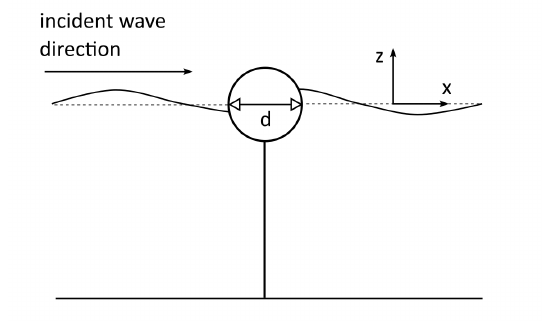
Figure 2. Semi-submerged spherical heaving buoy wave energy converter